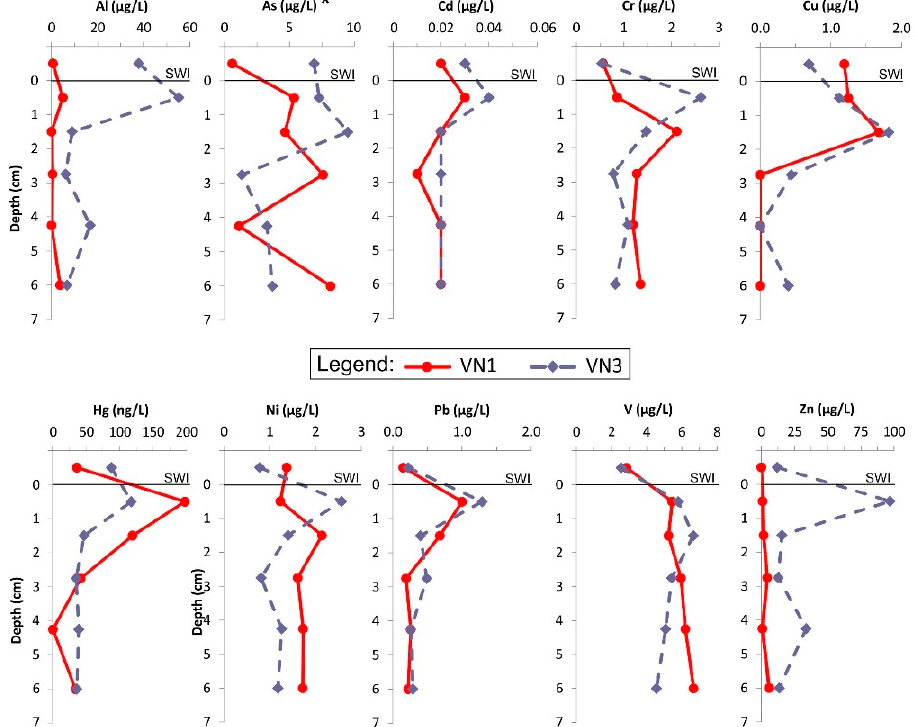
Figure 3. Vertical profiles of metal(loid)s in porewaters at both investigated sites. (*) For a better comparison of the results with those obtained for site VN3, the values of As in VN1 were graphically divided by a factor of 10.